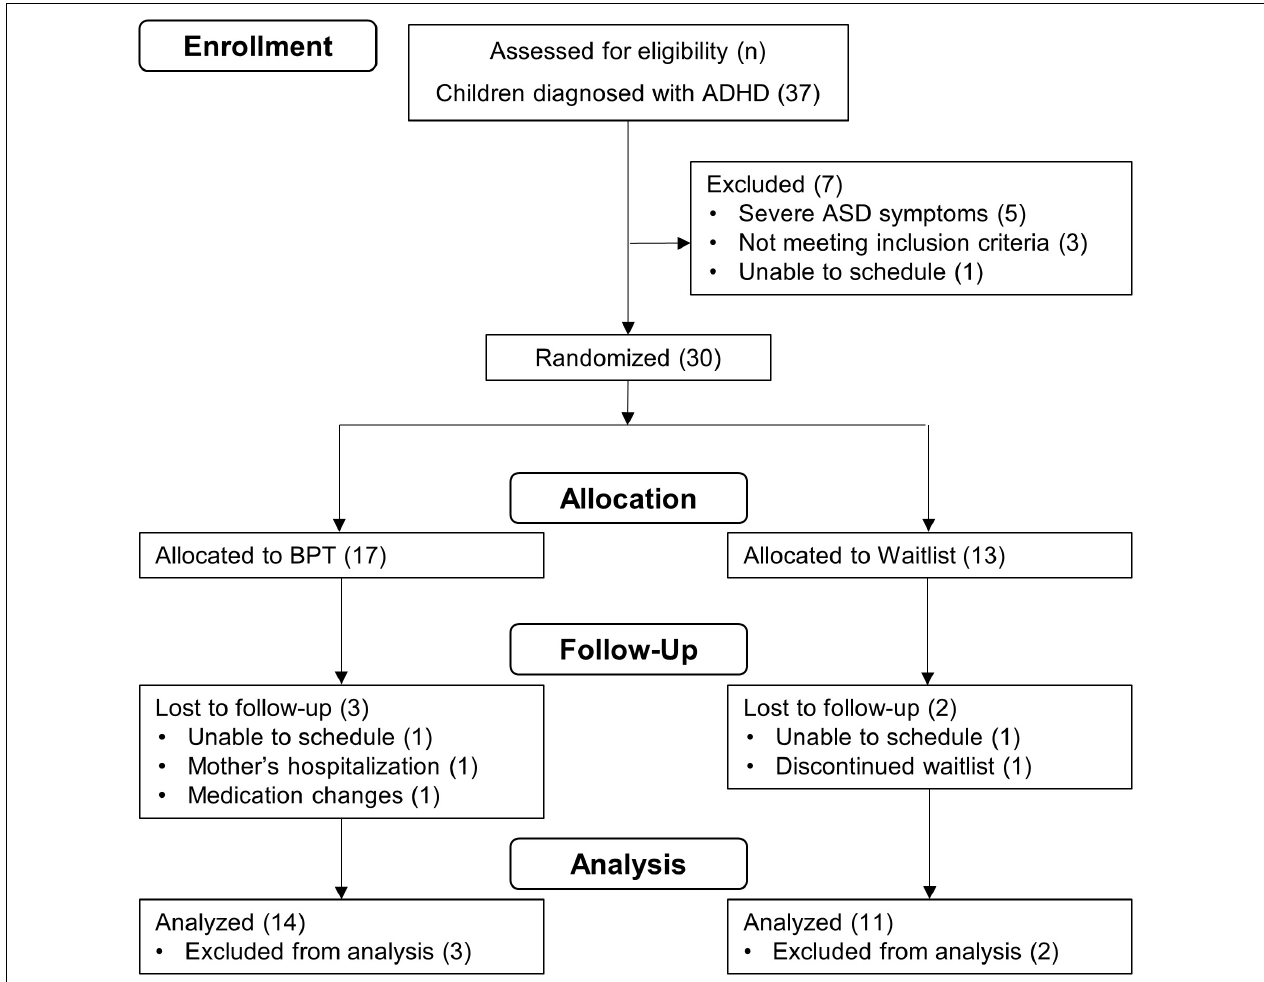
FIGURE 1 | Participant flow